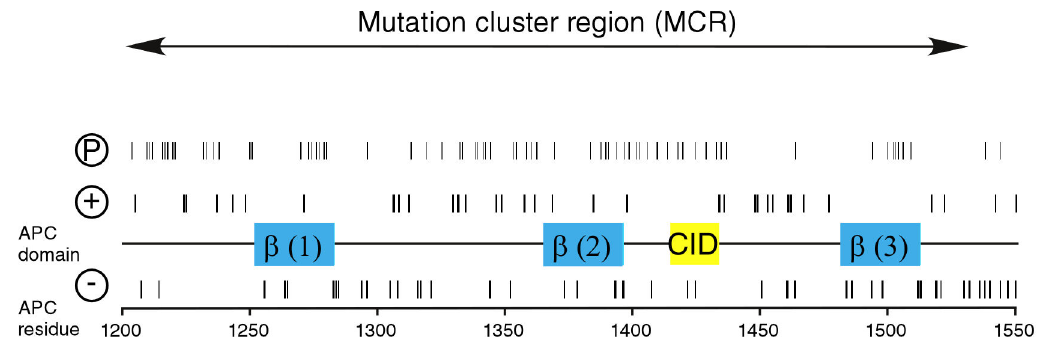
Figure 1. Charge distribution of APC-MCR. Charges present in the primary structure, putative phosphorylation sites and regulatory important motifs are indicated. A large number of putative phosphorylation sites scatter over the entire MCR (Phosida predictor for S/T phosphorylation). Two of the three 20 amino acid repeats (blue), bind to β-catenin (β). A short peptide stretch called “CID” (yellow) was recently implicated in Wnt/β-catenin downregulation [4,70]. doi: